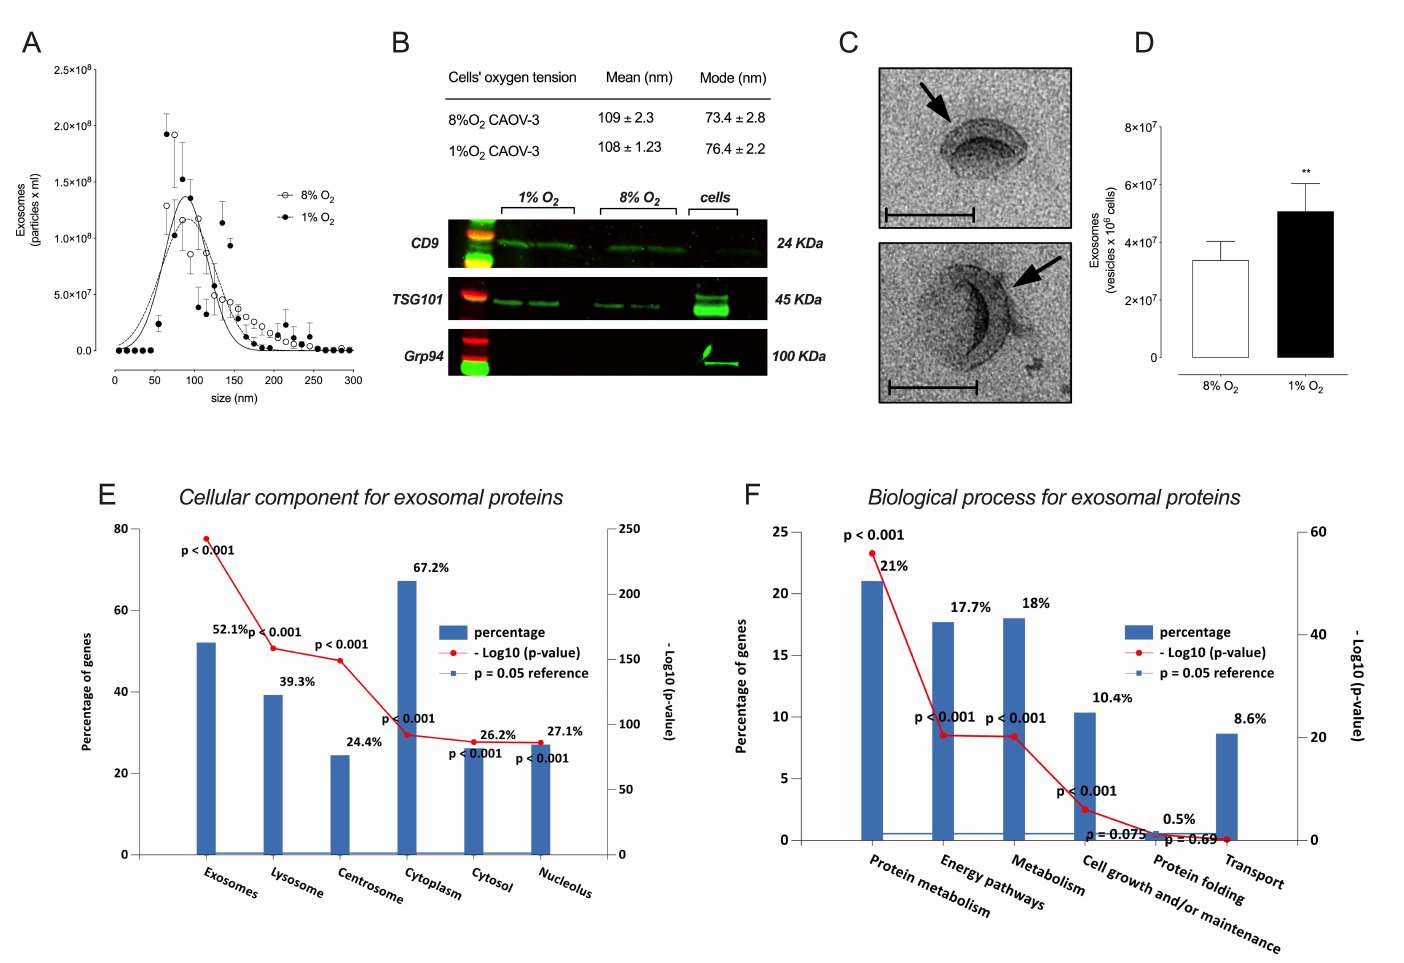
Figure 3. Isolation and characterization of 1% O 2 and 8% O 2 CAOV-3 derived sEVs. ( A ) Size distribution of sEVs isolated from 1% O 2 and 8% O 2 CAOV-3 derived sEVs determined using nanoparticle tracking analysis. ( B ) Representation of the mean and mode of the 1% O 2 and 8% O 2 and Western blot of exosomal protein markers CD9, and TSG101, and the negative control for both the 1% O 2 sEVs and 8% O 2 sEVs Grp94. ( C ) Transmission electron microscopy images of the isolated sEVs suggested the presence of vesicles. ( D ) Quantification of exosome particles from 1% O 2 and 8% O 2 sEVs presented as the number of particles/106 cells/48 h. ( E ) FunRich-based enrichment analysis of the exosome component from the SWATH analysis of sEVs. ( F ) FunRich-based enrichment analysis of the biological process of the exosome proteins. ** p <